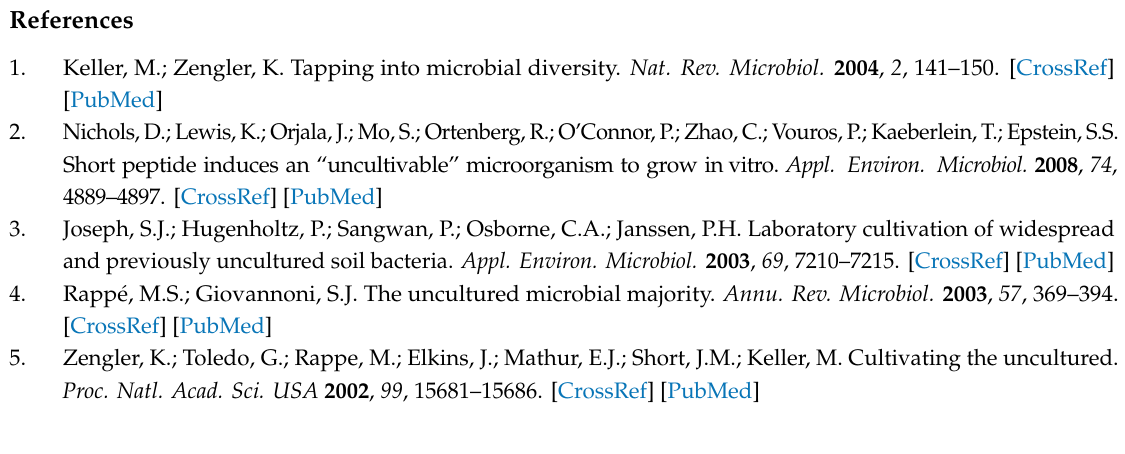
Figure S1: Shown are the bacterial ‘core’ microbiome at the genus level identified using 16S metagenomic libraries from the DC / MT gels, Figure S1: Shown are the fungal ‘core’ microbiome at the genus level identified using ITS metagenomic libraries from the DC / MT